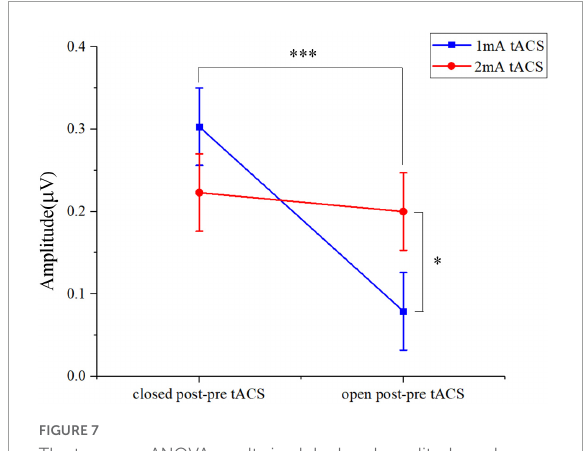
FIGURE7 The two-way ANOVA results in alpha band amplitude under tACS condition within 10 subjects who participated in both 1- and 2-mA stimulation. Closed post-pre tACS, the alpha amplitude differences between the pre- and post-tACS in the eyes-closed state; open post-pre tACS, the alpha amplitude differences between the pre- and post-tACS in the eyes-open state; ∗ p < 0.05, ∗∗∗ p <